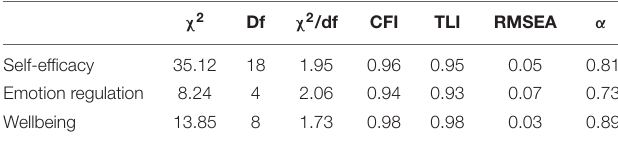
TABLE 1 | Measurement model of the latent constructs.